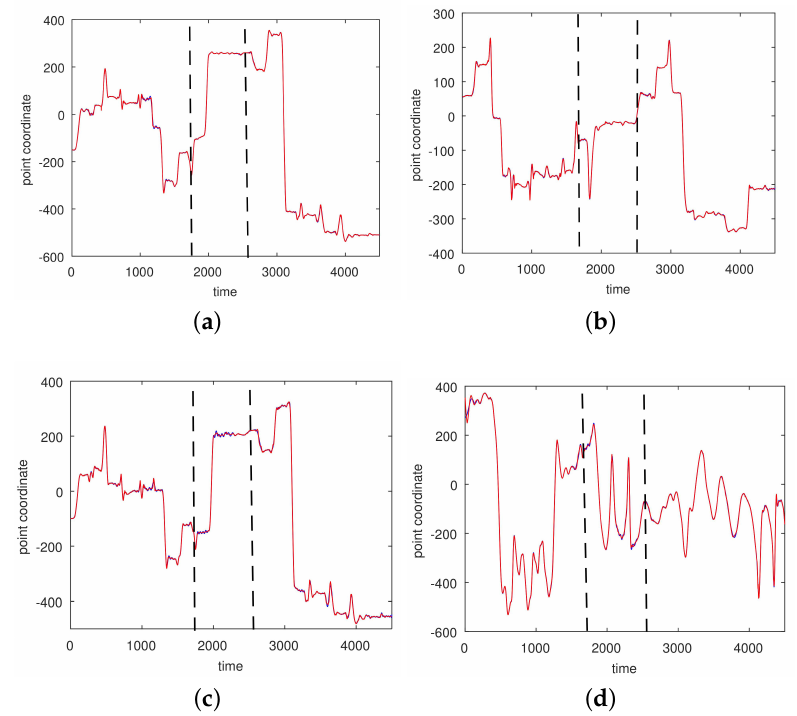
Figure 10. Approximations of x coordinates of a complicated motion (CMU 86 Trial 2; sampled at 120Hz) by a radial basis function (RBF) network with three centers and 100 satellites. The motion was segmented into three intervals [ 1,1800 ] , [ 1800,2500 ] , and [ 2500,4000 ] . ( a ) Right heel; ( b ) Left heel; ( c ) Right wrist, distal; ( d ) Left wrist,